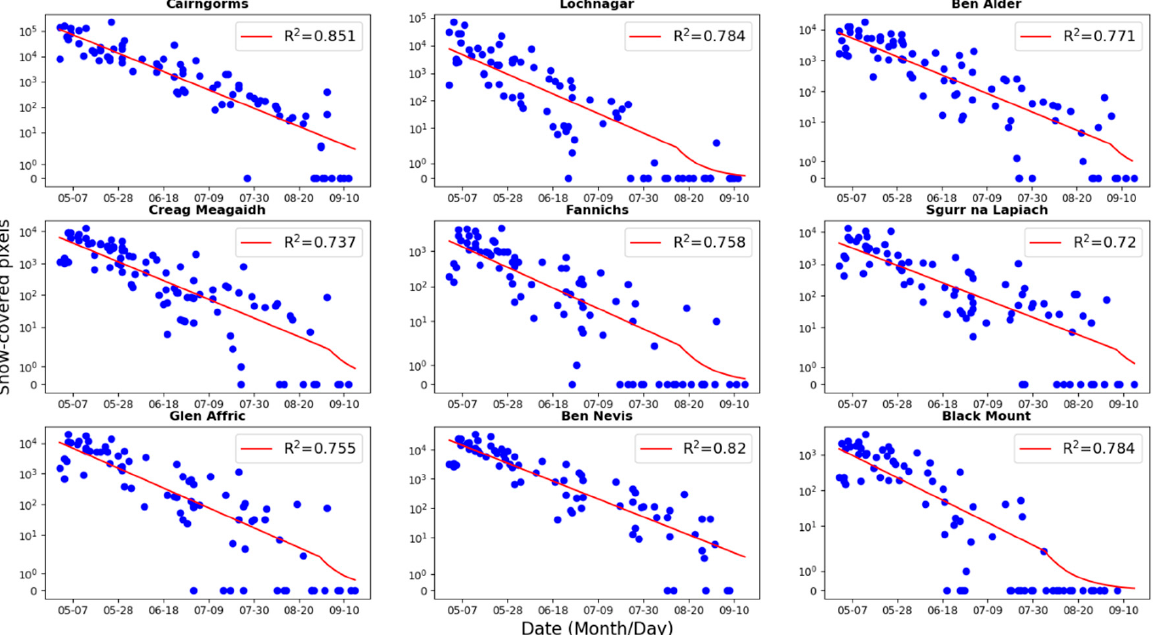
Figure 4. Curves of snow-covered pixels versus date for the nine sites in the study area. The red line shows the best-fit line for each site. Note the logarithmic scale of the y-axis.